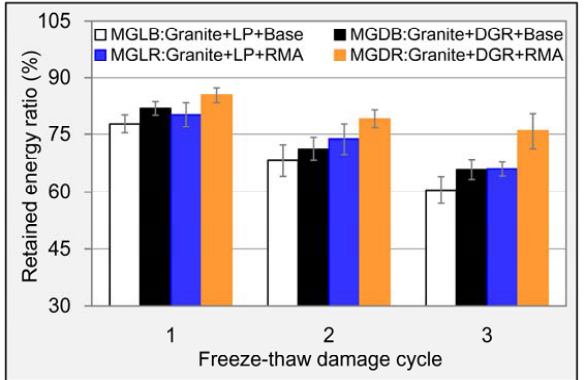
Figure 15. RER results of different asphalt mixtures.